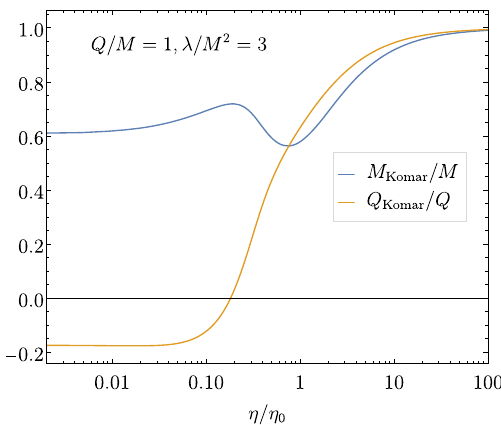
Fig. 5 Komarmassandchargeevaluatedat η/η 0 forsymmetricworm- holes are shown for coupling function (i) and Q / M = 1 and λ/ M 2 = 3